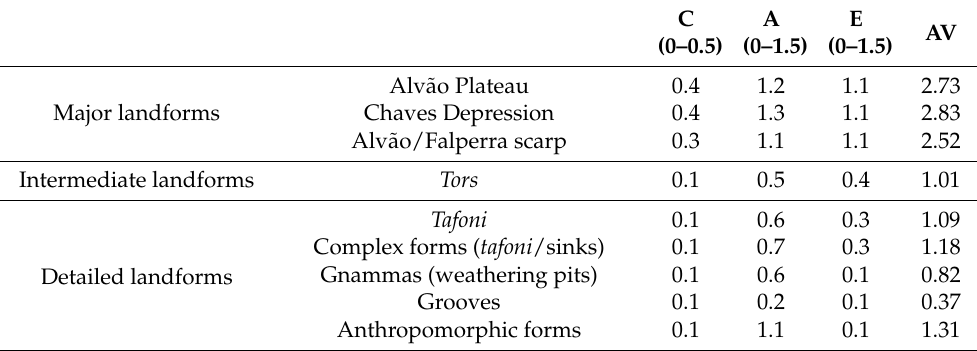
Table 2. Additional Value (AV) of the different geomorphosites.